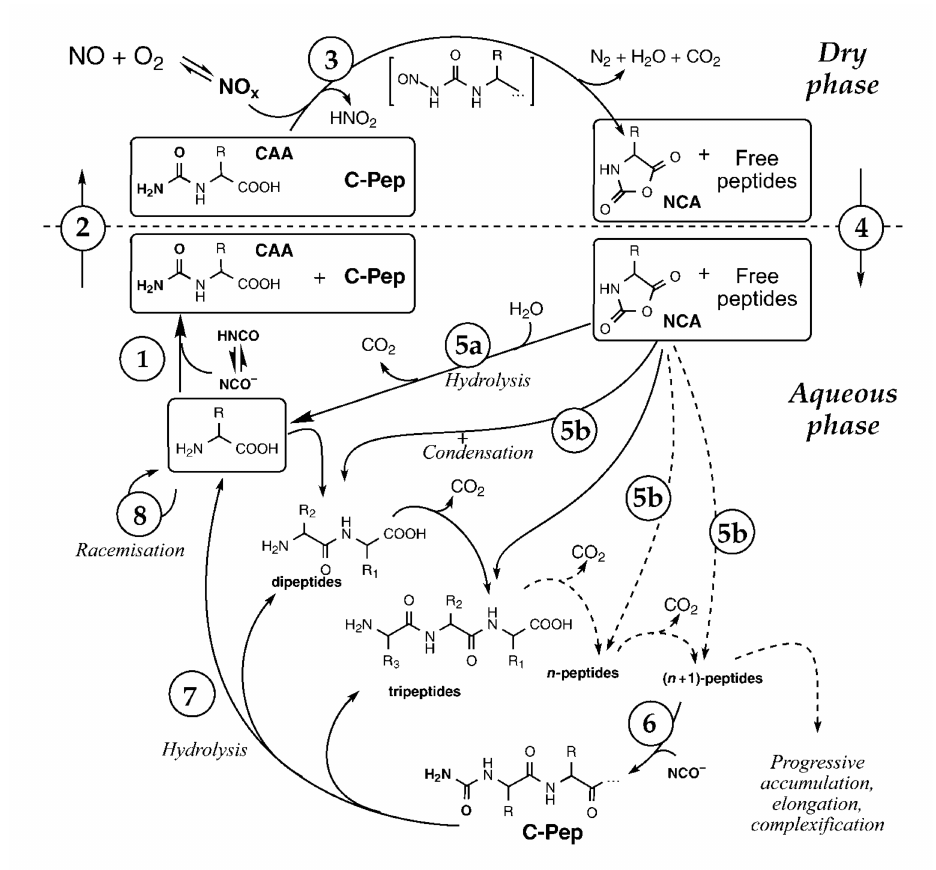
Figure 5. Proposed chemical pathway for peptide polymerization, using nitrogen oxide and a cyclic environment. From Ref. [89]. Reprinted with permission from Wiley, Hoboken, NJ, USA,